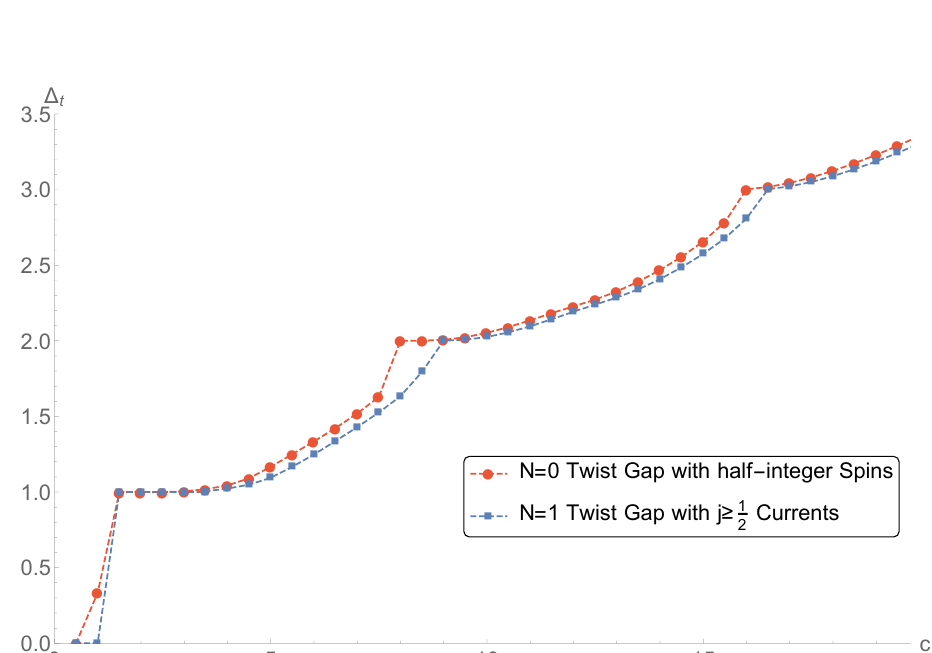
Figure 5 . Numerical upper bounds on the twist gap for the N = 0 ; 1 SCFTs with the conserved currents of j (cid:21) 1 . 2